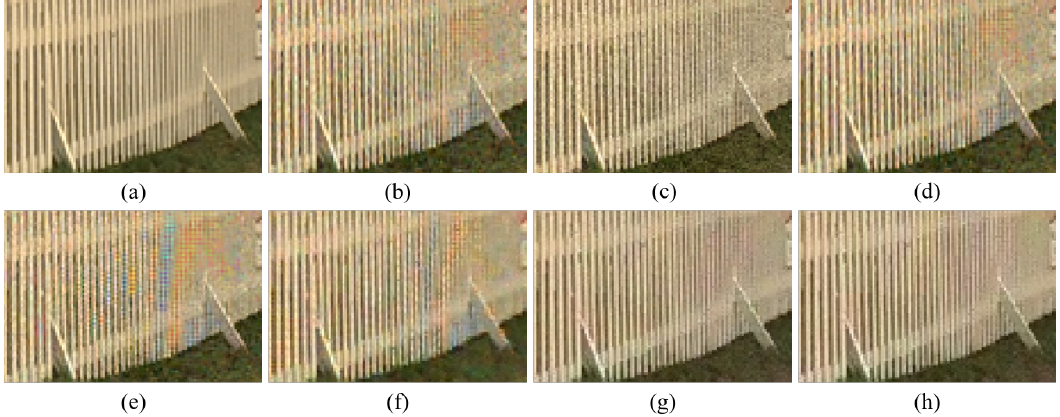
Figure 7. Showing the enlarged regions of Figure 6. ( a ) Original ( b ) ICC [12], ( c ) DNet [13] ( d ) RI